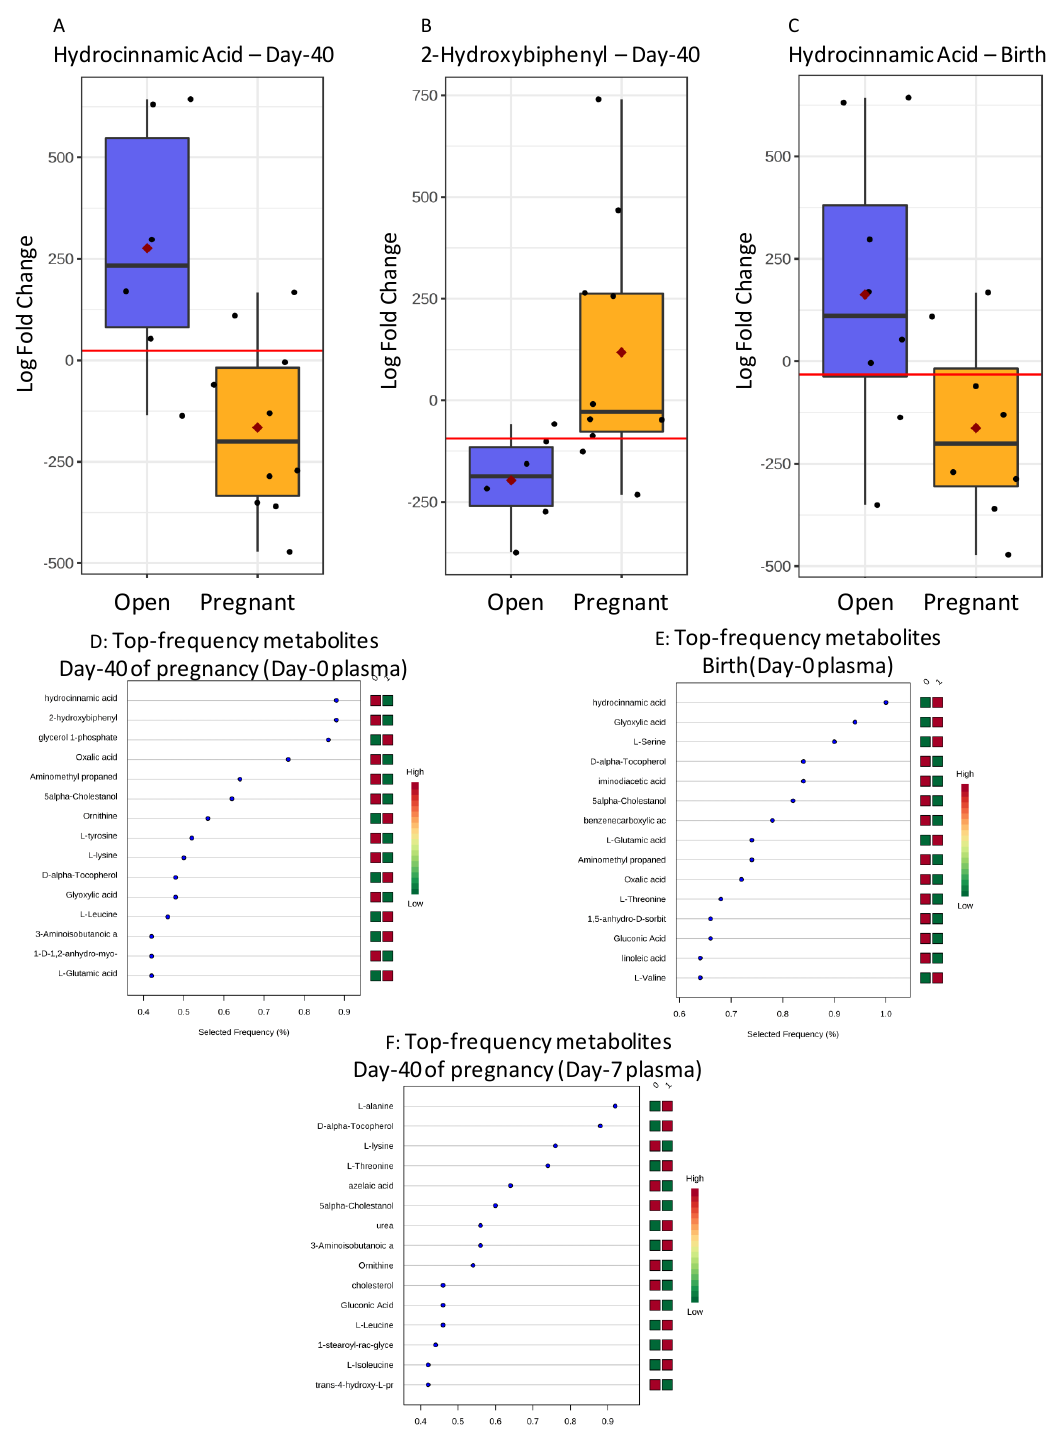
Figure 2. Boxplots of metabolite biomarkers of pregnancy viability measured in plasma of pregnant and open Holstein recipients on Day-0 (Hydrocinnamic Acid ( A ) and 2-Hydroxybiphenyl ( B ) at pregnancy Day-40 and Hydrocinnamic Acid at birth ( C )). Black dots represent the concentrations of all samples of each metabolite scaled as Log Fold Change values. The notch indicates the 95% confidence interval around the median. The mean concentration of each group is shown by a red diamond. The optimal cut-off is indicated as a horizontal red line (i.e., the closest to the left-hand corner in the corresponding ROC-AUC). Frequency rankings by a Support Vector Machine (SVM) algorithm for top biomarkers, including those of the above boxplots, are shown at gestational Day-40 on Day-0 plasma ( D ) and birth ( E ), and on Day-7 at birth ( F ) (1: Pregnant or birth to term recipients. 0: open